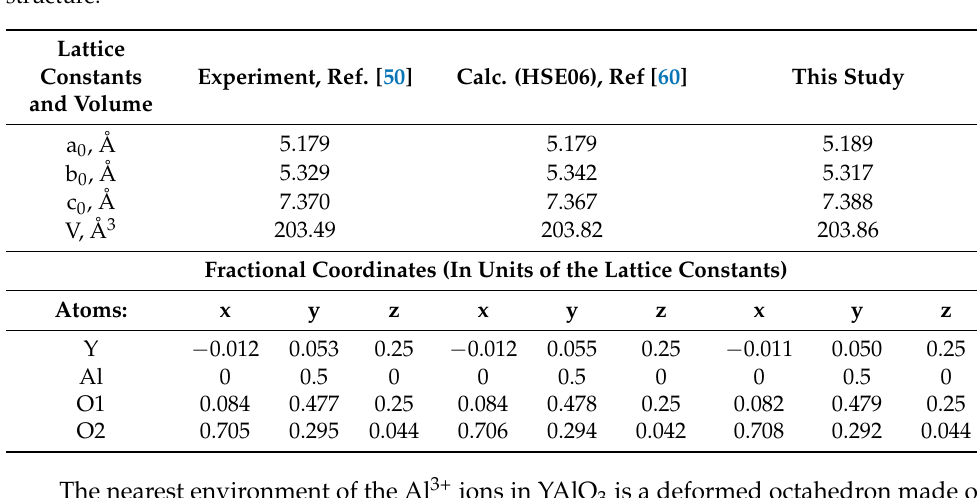
Table 2. Structural characteristics of YAlO 3 crystal in orthorhombically distorted Pbnm perovskite